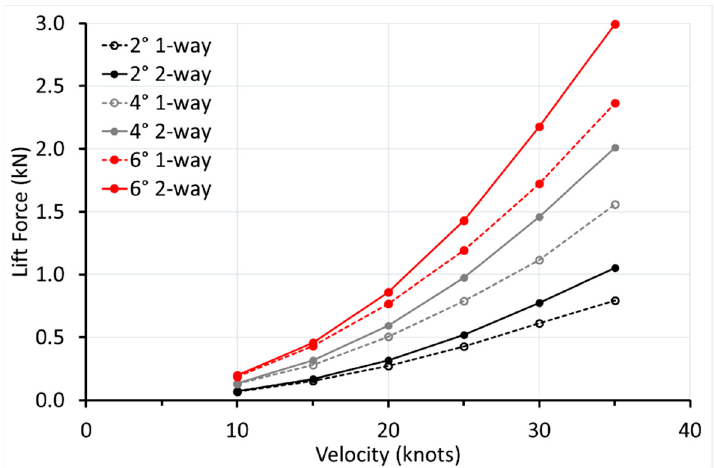
Figure 6. Lift force vs. velocity.